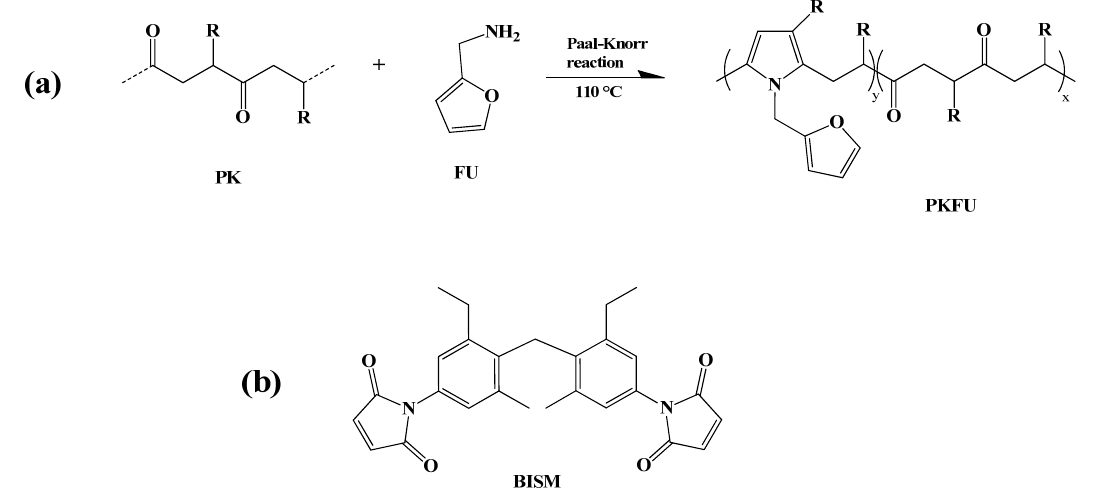
Figure 2. ( a ) Schematic representation of the polyketone modification with furfurylamine and ( b ) the chemical structure of the BISM .